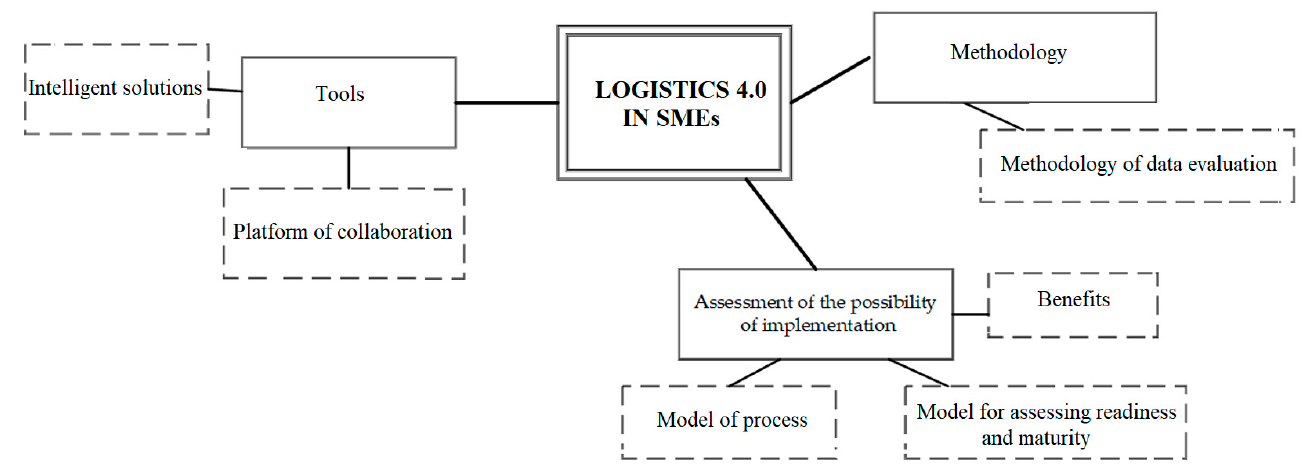
Figure 12. Classification of the scientific publications related to Logistics 4.0 in the SME sector. Source: own study.